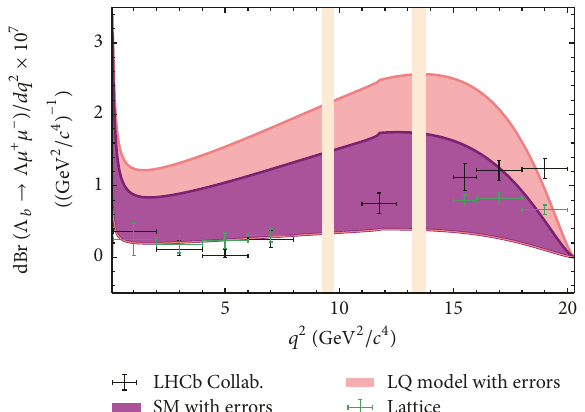
Figure 1: The dependence of the differential branching ratio on 𝑞 2 for the Λ 𝑏 → Λ𝜇 + 𝜇 − transition in the SM and LQ models. The experimental data are taken from the LHCb Collaboration [2]. The latticepredictionsareborrowedfrom[31].Theverticalshadedbands indicate the charmonia veto